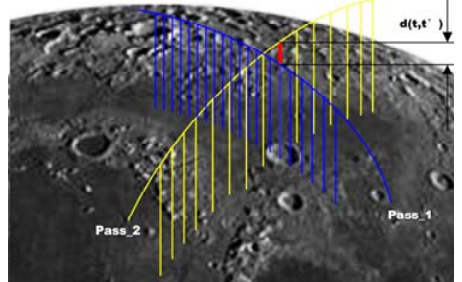
Figure 1. Altimetric crossover and crossover